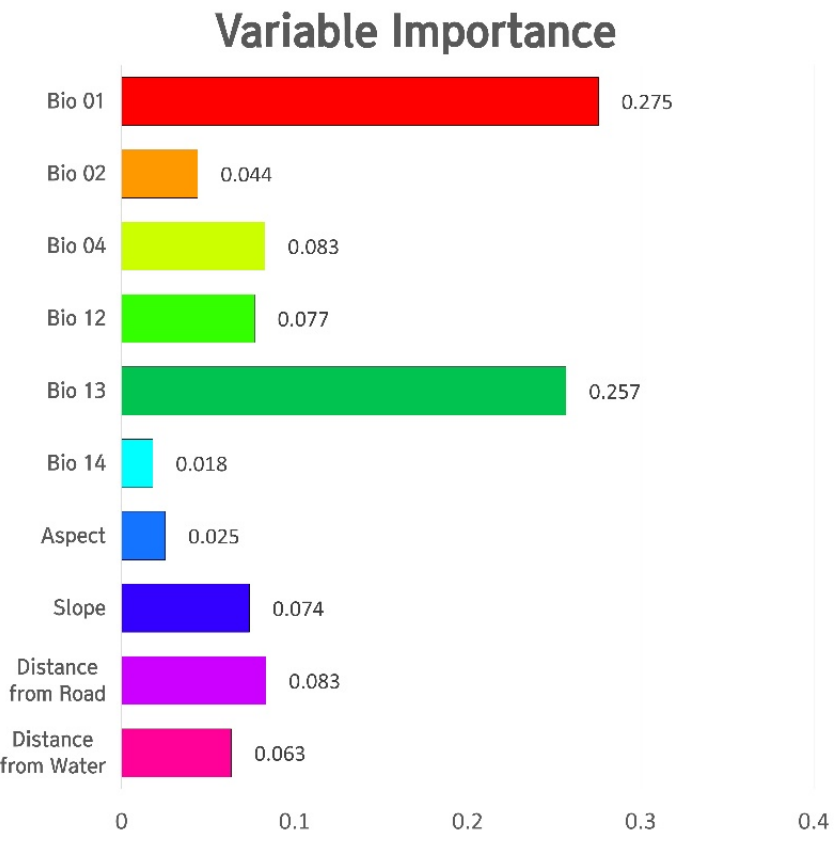
Figure 3. Bar plot showing values of variable importance.